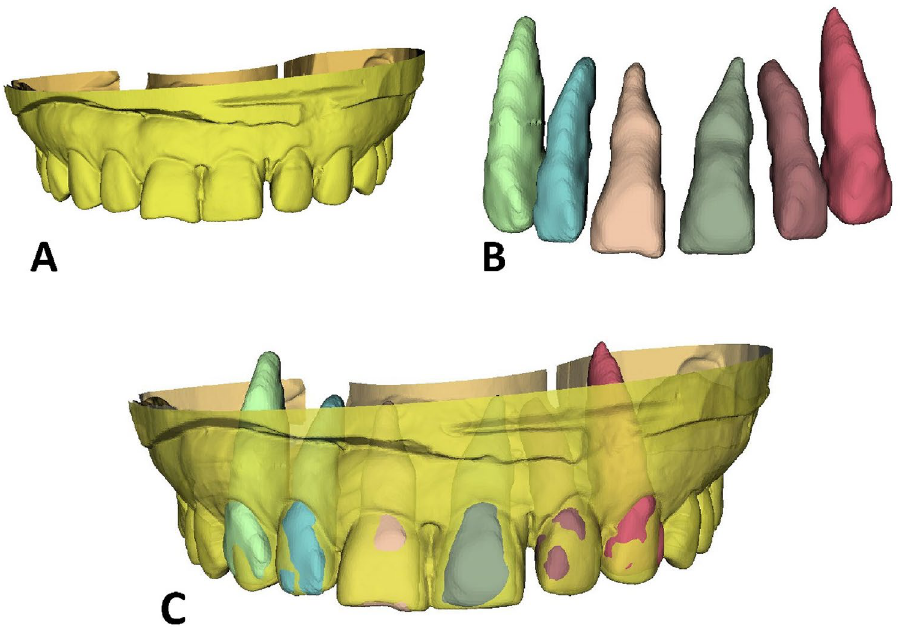
Figure 4. Dataset superimposition. ( A ), A scan image in the STL file format. ( B ), DICOM segmentation and STL conversion. ( C ), Superimposition of two STL files.